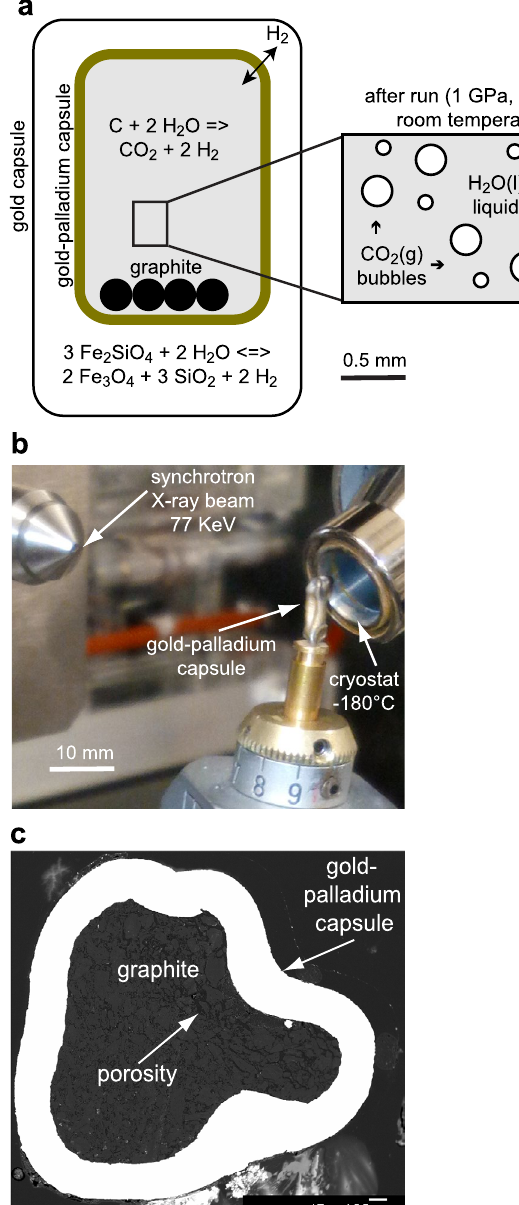
Figure 1. Experimental and analytical setup. ( a ) Sketch of the experimental capsule, consisting of an outer gold capsule containing an f H 2 – f O 2 buffering assemblage (FMQ = fayalite + magnetite + quartz + water) and an inner gold–palladium capsule (brown thick line), permeable to hydrogen, containing graphite + water. At run conditions of 1 GPa, 800 °C and f H 2FMQ , the oxidation of graphite produces CO 2 . ( b ) The inner gold–palladium capsule containing graphite and a mixed H 2 O–CO 2 fluid is mounted on a goniometer head and cooled down to − 180 °C to allow the fluid to freeze into solid phases; X-ray diffraction effects inside the noble-metal capsule are collected using a high-energy 77 keV synchrotron source at ID15A of the ESRF. ( c ) Back-scattered electron image of a cross section of the inner capsule (white), mounted in epoxy resin and polished after synchrotron and QMS measurements; the former presence of a fluid phase can be inferred from the porosity between the graphite